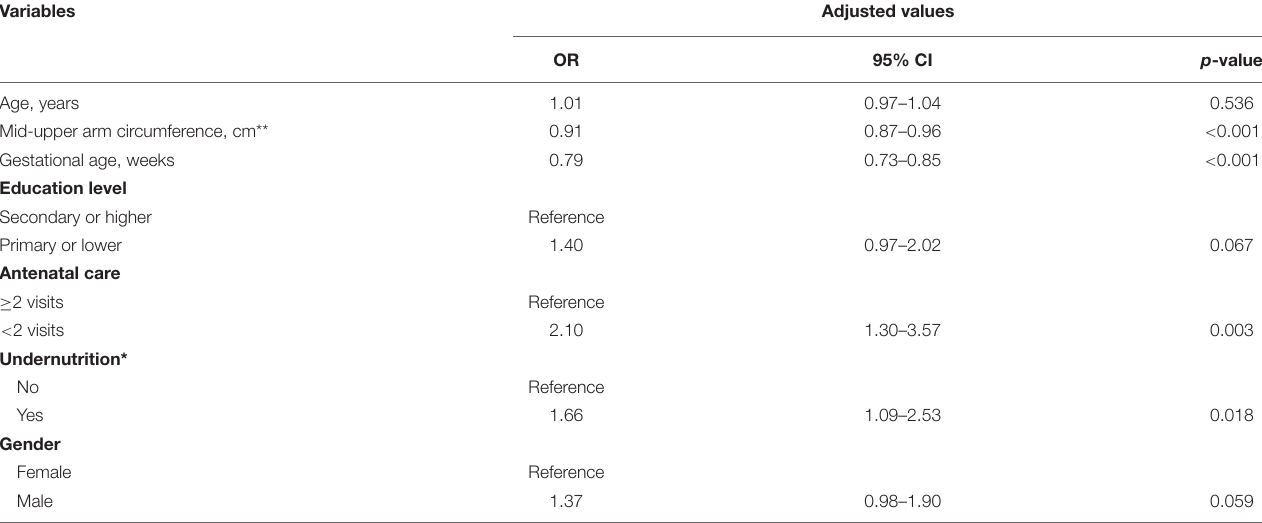
TABLE 2 | Logistic regression analysis of the factors associated with low birth weight in Khartoum, Sudan,